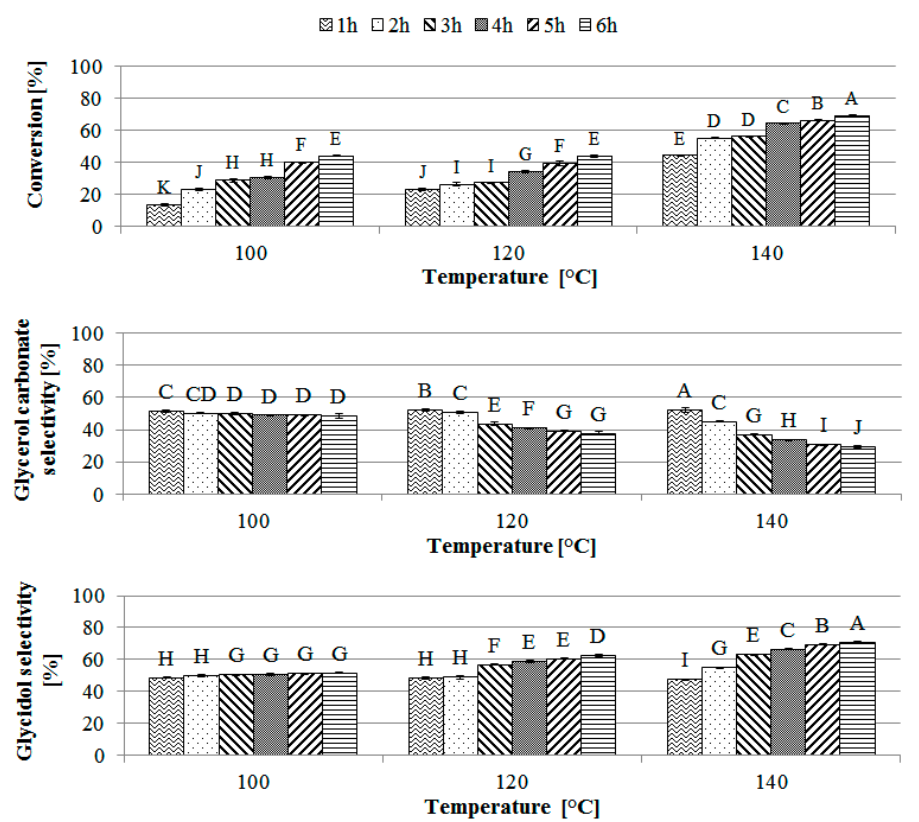
Figure 5. The influence of temperature on the catalytic performance of a biosolids-based catalyst. Reactions were carried out using a catalyst:glycerol ratio of 9% (wt/wt), a 2:1 molar ratio of urea:glycerol, and an air stream. The conversion and selectivity at three different temperatures were examined: 100 °C, 120 °C, and 140 °C. The errors represent the standard deviations calculated according to the values of three experiments. The means of triplicate experiments are reported, with the error bars representing standard deviation. Data annotated with different letters are significantly different (confidence level of 95%).